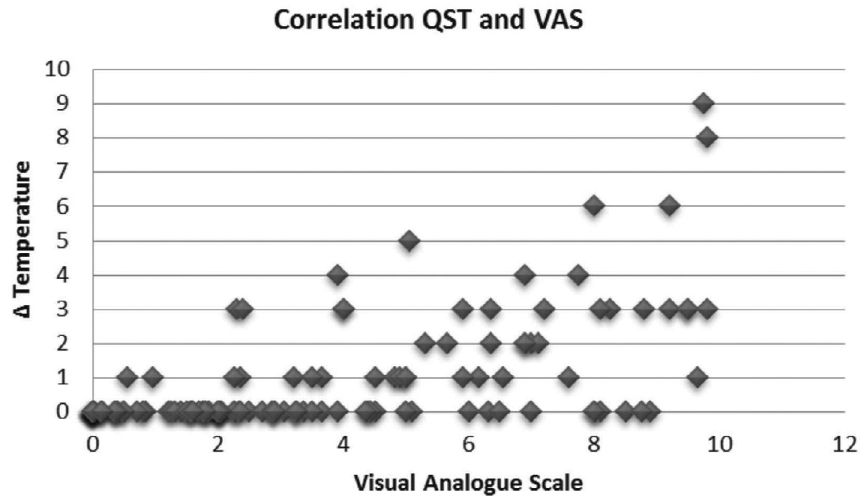
Figure 11- Correlation Test between dental sensitivity intensities determined using Visual Analogue Scale (VAS) and Quantitative Sensory Testing (QST) (Group II - High